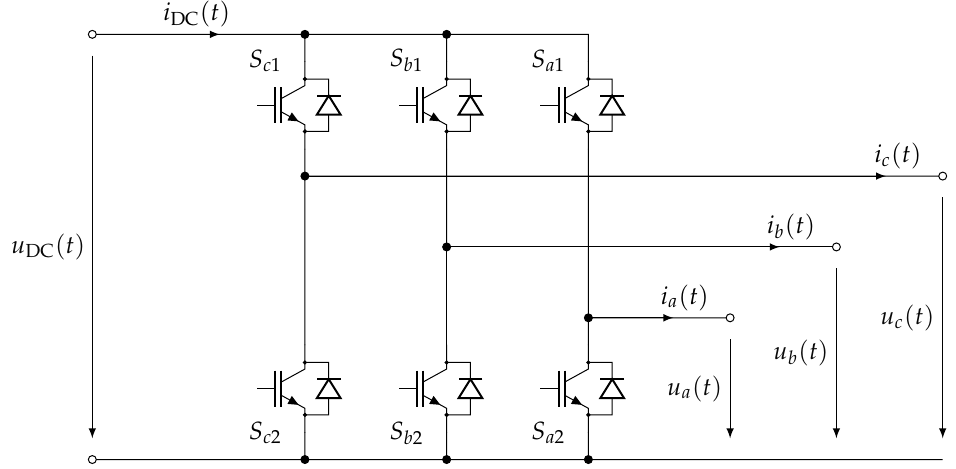
Figure 7. Circuit diagram of a two-level